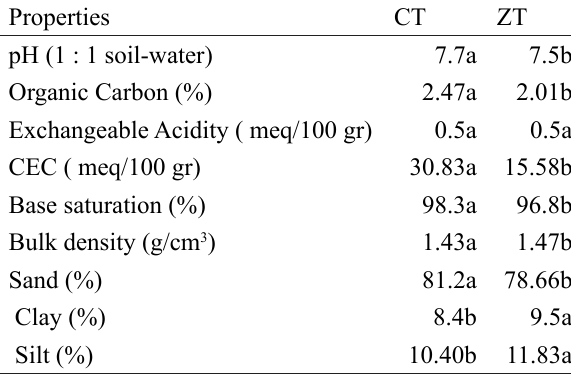
Table 2: Soil Properties during Early Season Properties